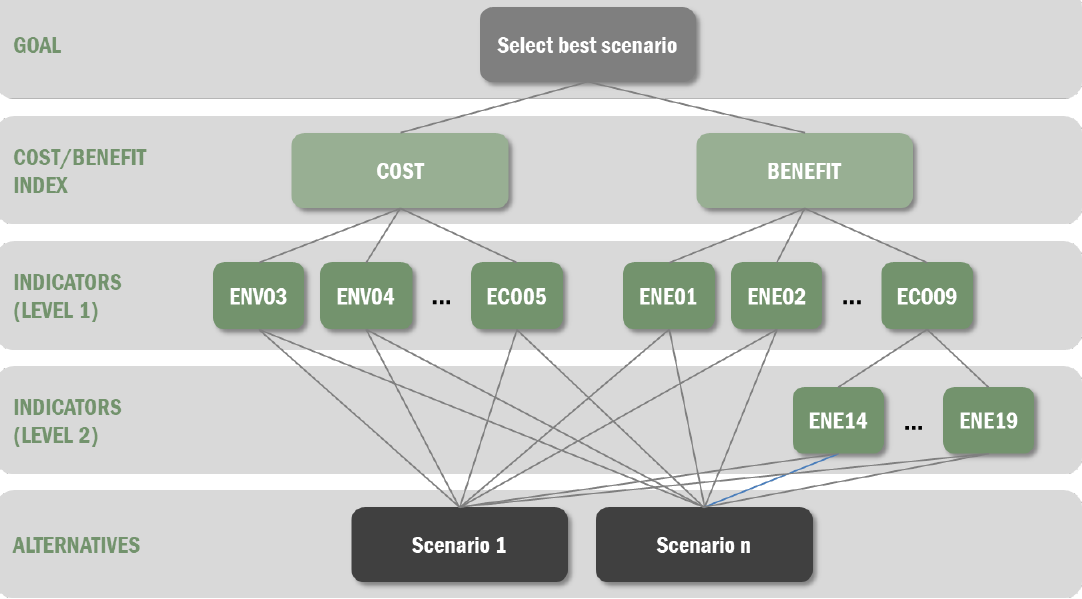
Table 2. The fundamental scale of absolute numbers. Adapted from [35].